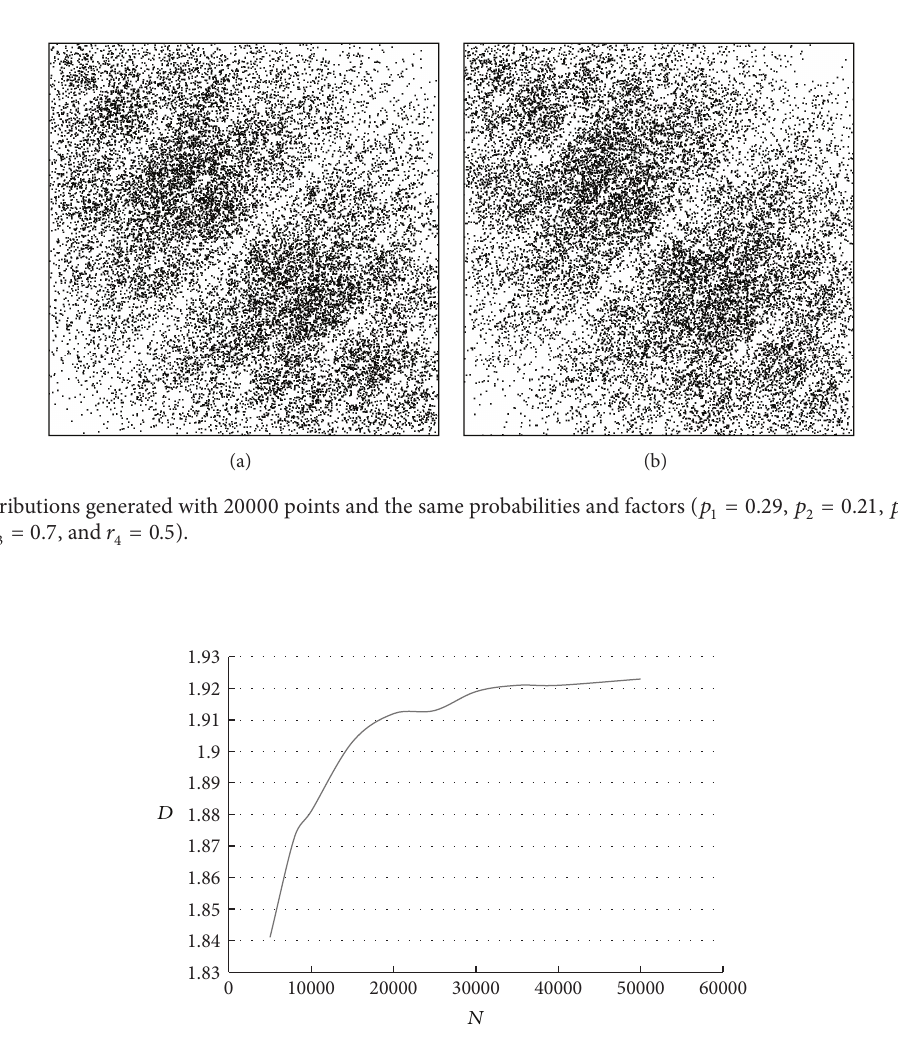
Figure 4: Value of the estimated entropy dimension 𝐷 for increasing number of points 𝑁 .